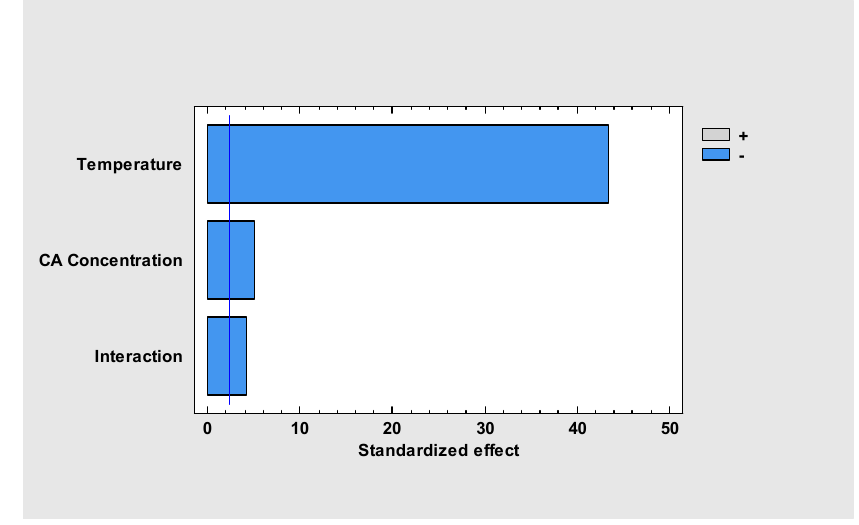
Figure 2. Temperature and concentration effects on CA final concentration.